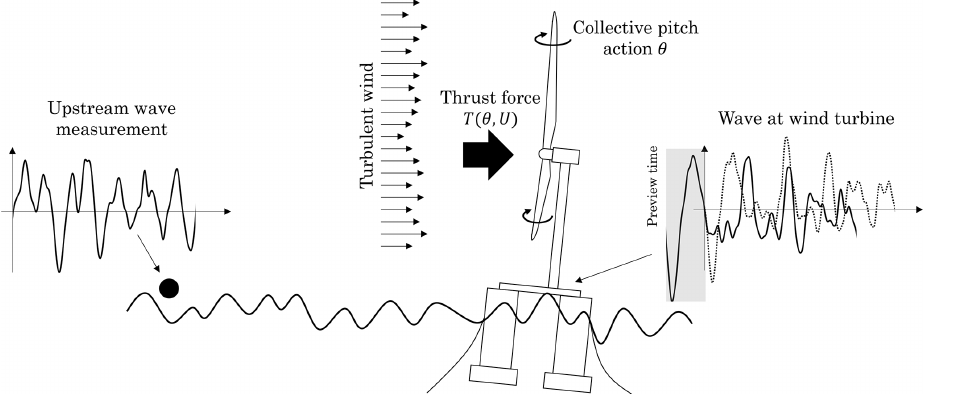
Figure 10. Schematics of the wave-feedforward control strategy. Waves excite the floating platform and generate a varying apparent wind speed for the rotor. The oscillating wind results in rotor speed fluctuations which are only partially rejected by the standard feedback controller. The feedforward action is based on the wave elevation measured upstream of the wind turbine. This measurement is used to obtain a preview of the wave elevation at the floating platform, which is the input of the controller. The resulting collective-pitch action, which is summed to the pitch request from the feedback controller, counteracts the wave disturbance, modifying the aerodynamic torque and the rotor thrust force.